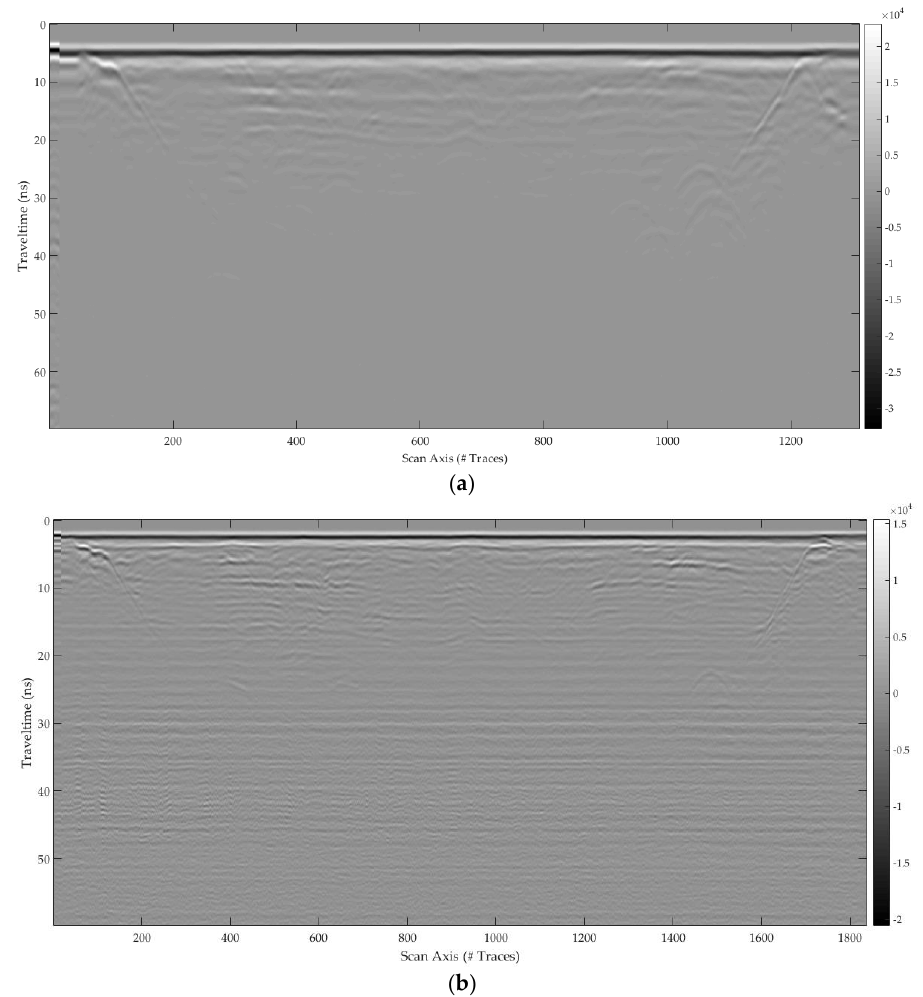
Figure 35. Profiles recorded in the Gneiss 0/20 gravel region by using GPR 1, on acquisition line 1, with antennas operating at: ( a ) 400 MHz; ( b ) 900 MHz.